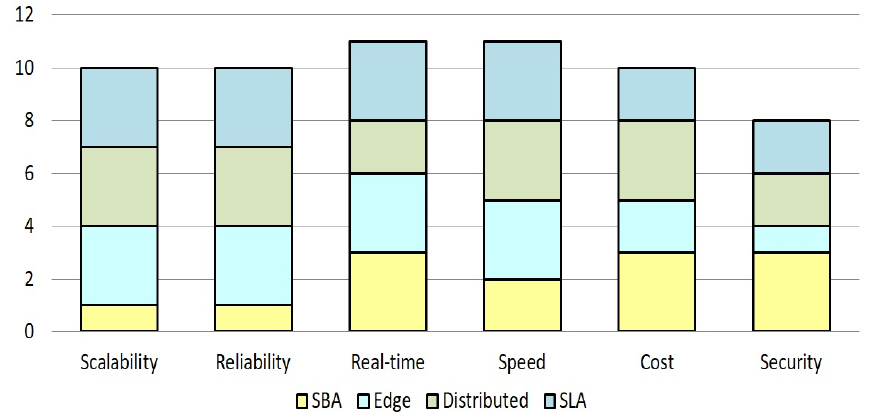
Figure 7. A qualitative analysis of different Ouality of Service (QoS) parameters for the studied technologies with the proposed Serverless Approach (SLA)